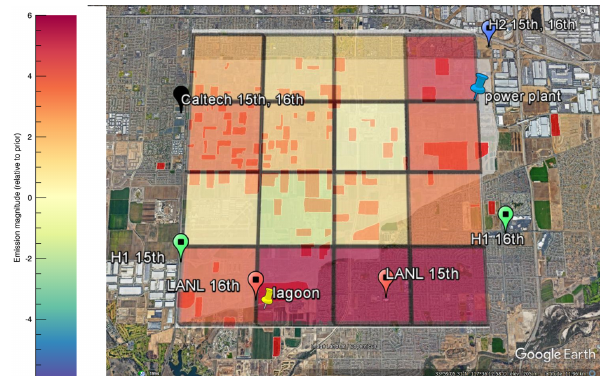
Figure 12. Map of the a posteriori X CH fluxes (mean of 15 and 4 16 January runs) from the WRF-LES simulations normalized by the a priori emissions and superimposed on a Google Earth map, where the dairy farms are represented by the red areas as shown in Fig. 1. The domain is decomposed in 16 boxes (2km × 2km), in which the colors correspond to the a posteriori emissions from the WRF-LES inversions. Red (blue) colors mean more (less) CH 4 emissions than dairy cows in that box. A multiplicative ratio of 1 is equivalent to a flux of 2150molkm − 2 h − 1 . The locations of the lagoon (yellow pin) and the power plant (blue pin) are also added to the map. Map provided by Google Earth V 7.1.2.2041, US Dept. of State Geographer, Google, 2013, Image Landsat, Data SIO, NOAA, US, Navy, NGA, and